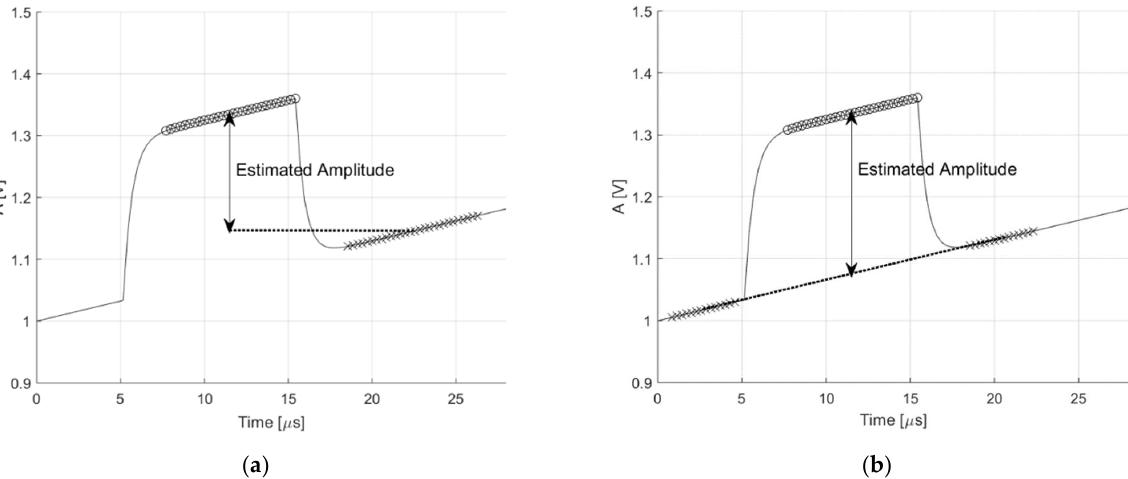
Figure 4. Estimated amplitude of the pulse. ( a ) Single-side digital baseline restorer and ( b ) the proposed double-side digital baseline restorer.